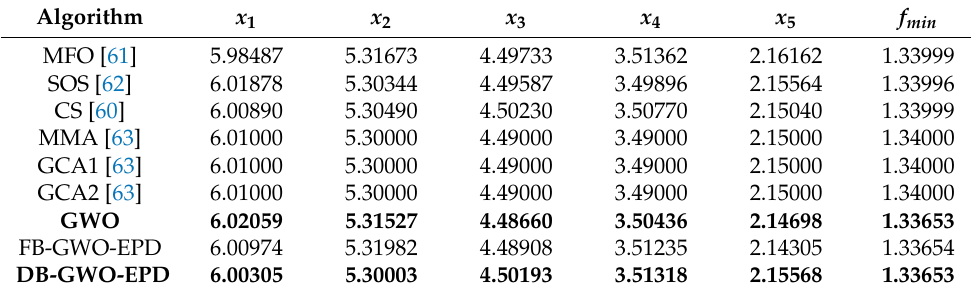
Table 11. Results of solving cantilever beam design problem.